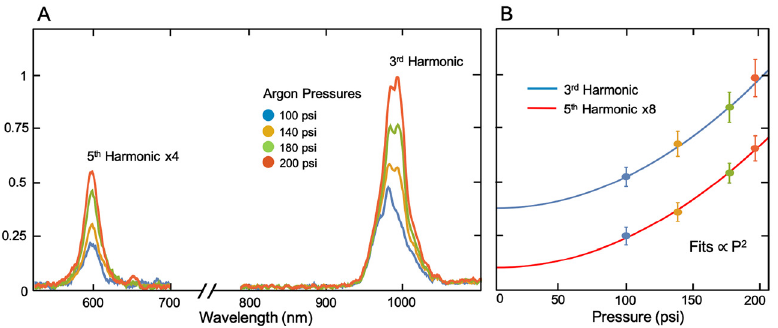
Figure 4: Pressure dependence of mid-infrared device. (A)Thirdandfifthharmonicsofa2.9- μ mpumpbeamona2.9- μ